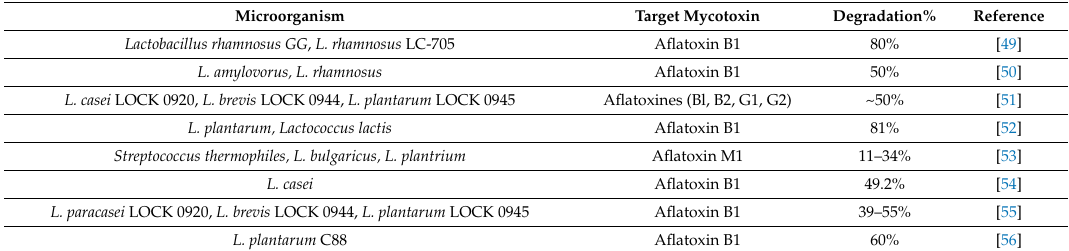
Table 2. Lactic acid bacteria reported applications for mycotoxins degradation in foods and